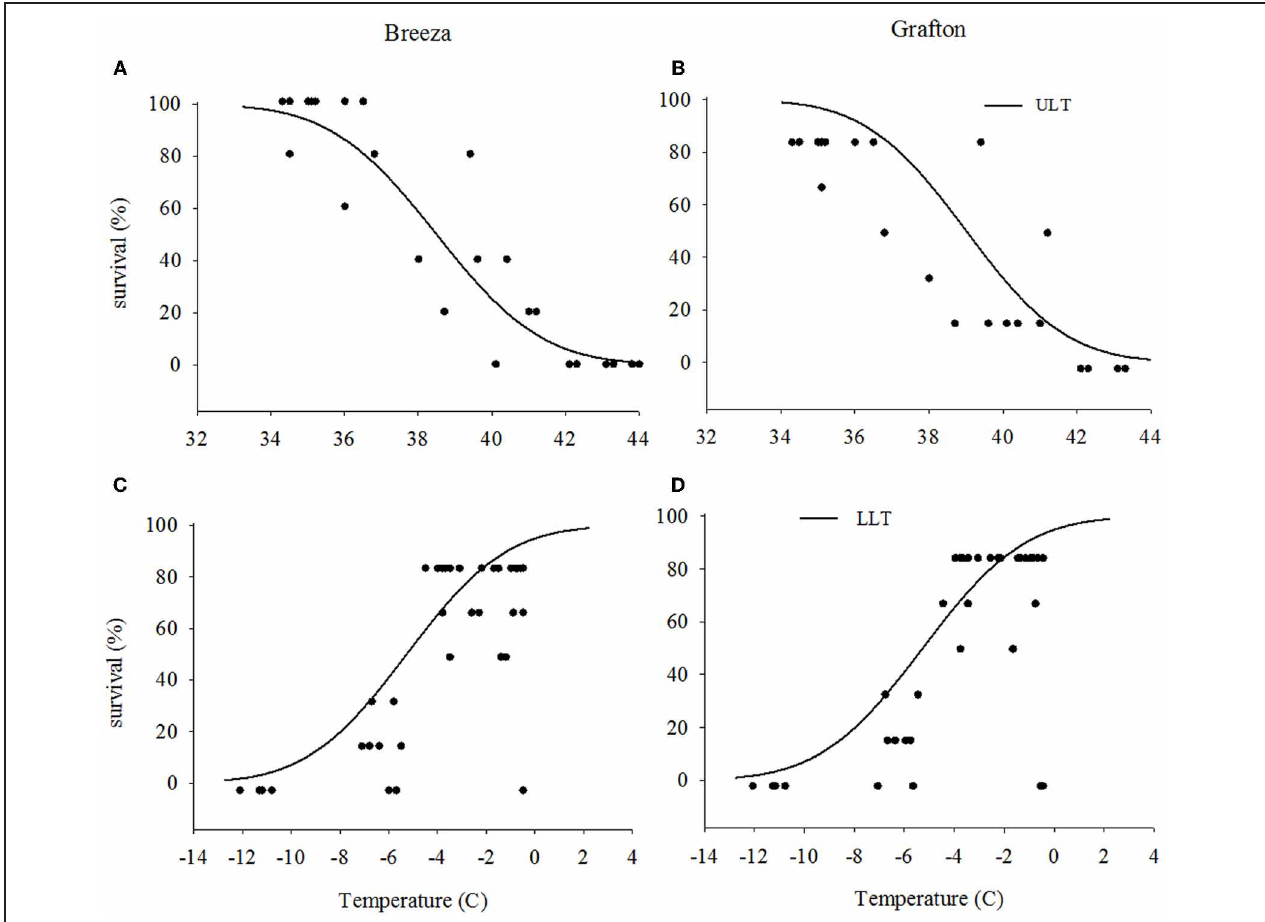
FIGURE 1 | Upper and lower lethal temperatures (ULT and LLT) of Nezara viridula (L.) populations from Breeza (A and C) and Grafton (B and D) for the high and low temperature (the distribution of dots are represented raw